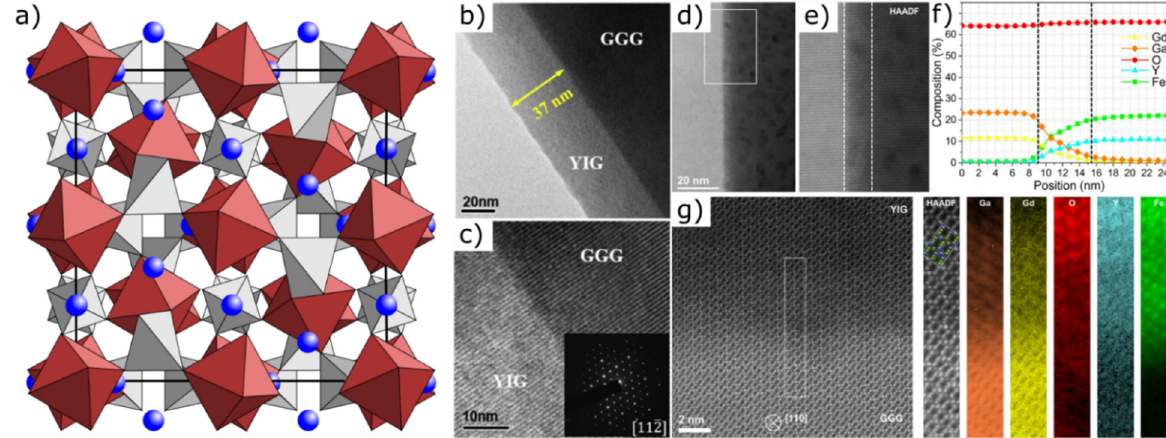
Figure 3. ( a ) Unit cell of garnet A 3 B 2 C 3 O 12 (A: blue, BO 6 : red, CO 4 : grey). ( b , c ) TEM cross-section images of a YIG/GGG (111) thin film grown at 850 °C for 3 h with a thickness of 37 nm (inset: diffraction pattern of the interface). Reprinted from Ma et al. [168]. Copyright 2021, with permission from Elsevier. ( d ) HAADF overview image of a YIG/GGG interface (YIG: right, GGG: left). The white rectangle indicates the region over which the electron energy loss spectroscopy (EELS) imaging in ( f ) was carried out, providing averaged compositional profiles. ( e ) HAADF intensity of the YIG/GGG interface. White dotted lines indicate a ∼ 6 nm wide region where some interdiffusion of Gd, Y, Ga, and Fe is observed (corresponding to the area marked with dotted lines in ( f )). ( g ) High magnification EELS analysis of the interface (rotated 90 degrees to ( d )) in the region indicated by a white rectangle on the HAADF overview image. Maps for Ga, Gd, O, Y and Fe are shown, together with the simultaneously recorded HAADF intensity, over which a sphere model of YIG in [110] orientation is superimposed (green spheres represent Fe, blue spheres Y and oxygen is not shown for clarity) [163].